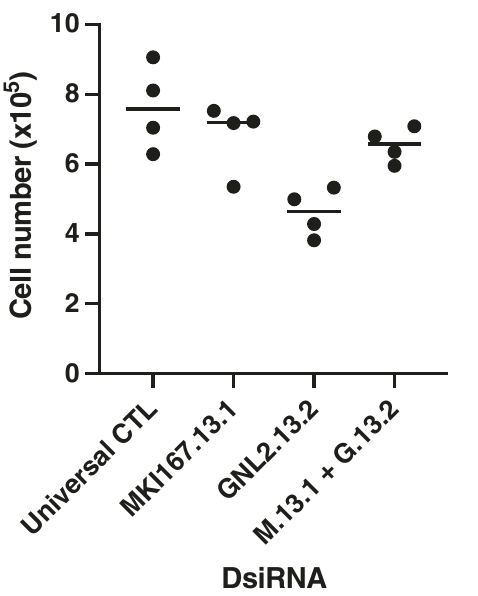
Fig. 7 Effect of MKI67 and GNL2 knockdown on proliferation of HEK293T. Each siRNA was added at 20 nM in a culture with 1 × 10 5 cells, except for the double knockdown where each siRNA was added at 10 nM to make the total concentration 20 nM. Each dot on the diagram shows cell number of an independent culture. Results of the t -test for CTL KD vs MKI67 KD, CTL KD vs GNL2 KD, MKI67 KD vs GNL2 KD, and GNL2 KD vs MKI67 KD + GNL2 KD are P = 0.34, 0.005, 0.010, and 0.003,